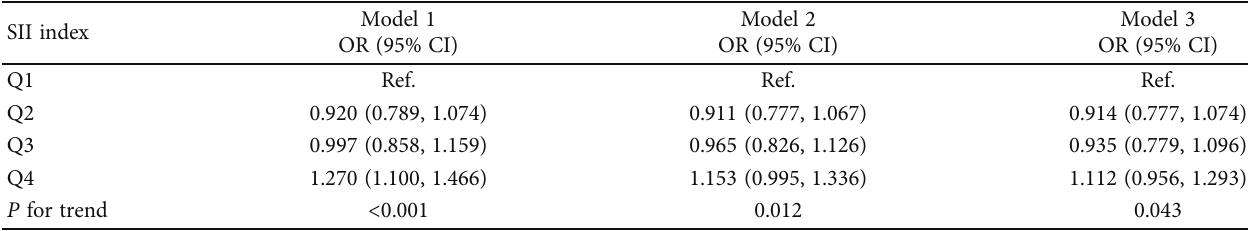
Table 2: Adjusted ORs for associations between SII index and the incidence of total CVD.